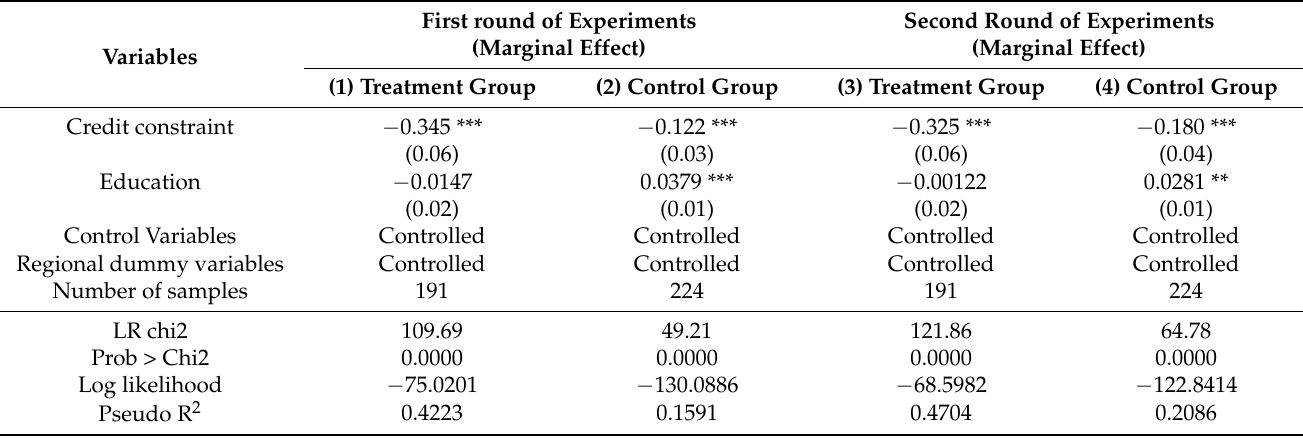
Table 10. Differences in farmers’ acceptance of interlinked insurance and credit